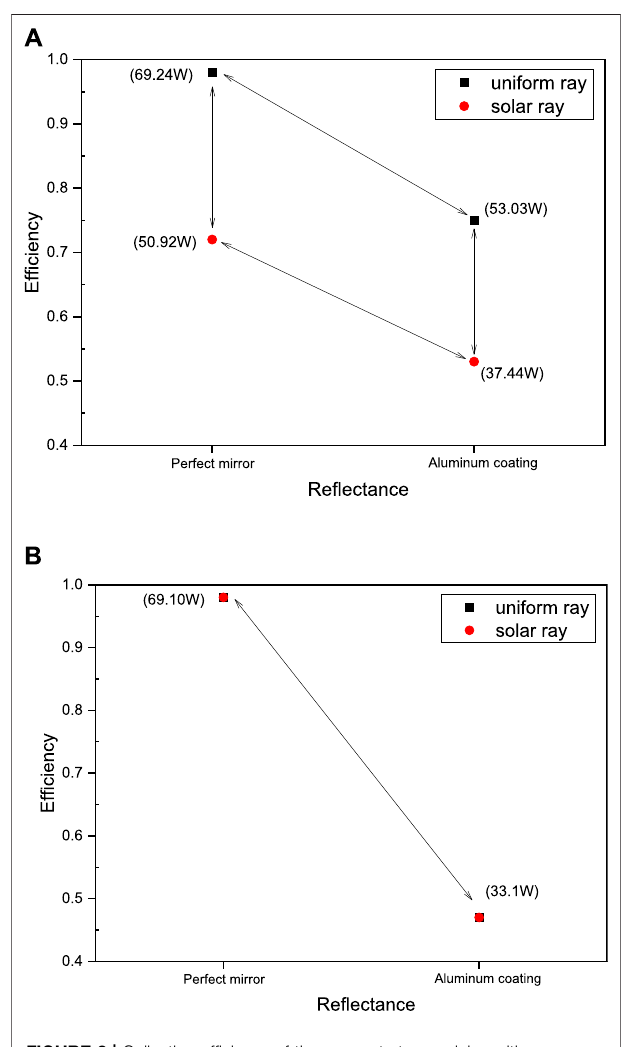
FIGURE 8 | Collection ef fi ciency of the concentrator modules with different re fl ectance and different ray sources: (A) CM-1 and (B) CM-2.